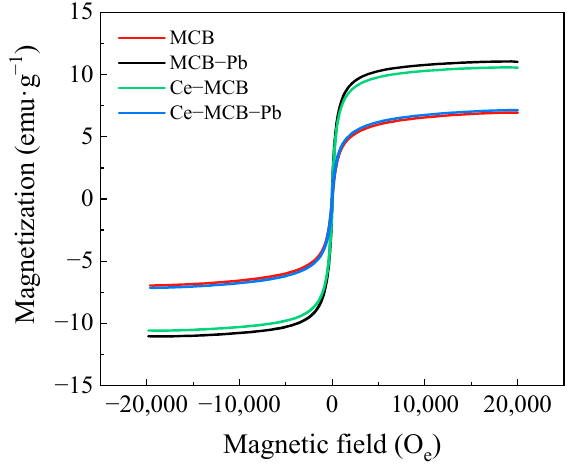
Figure 7. Magnetization curve of MCB and Ce-MCB.